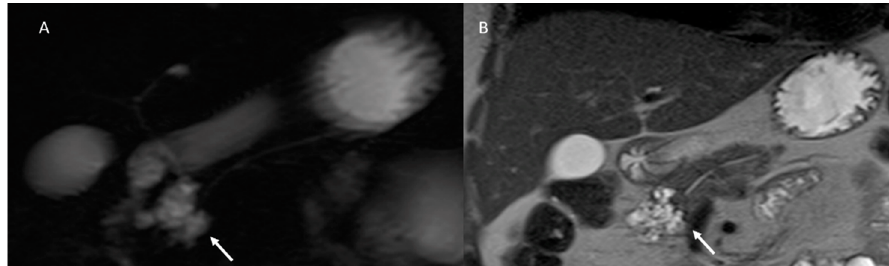
Figure 5. EUS evaluation ( A , B ); cystic lesion (arrows) appears as a heterogeneous hypo-isoechoic mass.